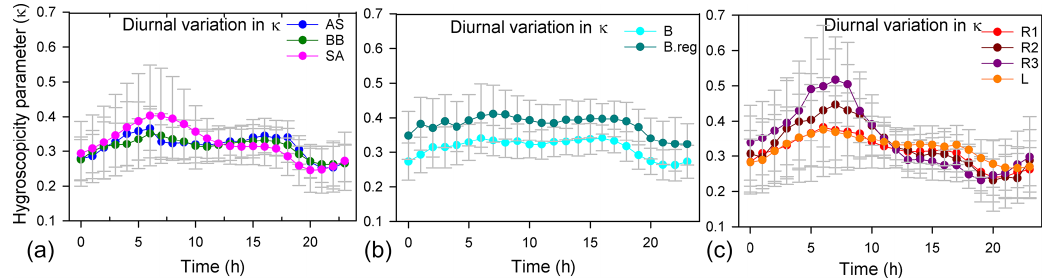
Figure 4. Diurnal variation in κ with time. Panel (a) is for AS, BB, and SA; panel (b) is for BB branches (B and B.reg), and panel (c) is for SA branches (L, R1, R2, and R3).